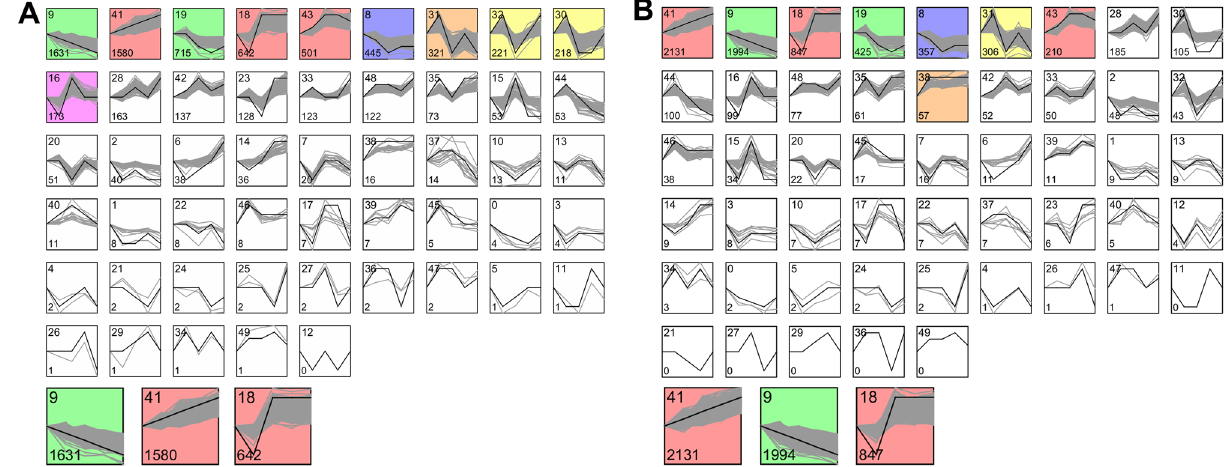
Figure 3. Time-series analysis of production stage-specific jejunal transcripts expressed in LB ( A ) and LSL ( B ). Expression patterns (grey lines) over the five selected production stages at week 10, 16, 24, 30 and 60 were clustered into profiles. Colors are assigned to only significant profiles ( p < 0.05) and ordering is based on number of genes displayed in the lower left corner. The profile number is shown in the upper left corner. Highlighted profiles #9, #41, and #18 were selected for detailed analyses via